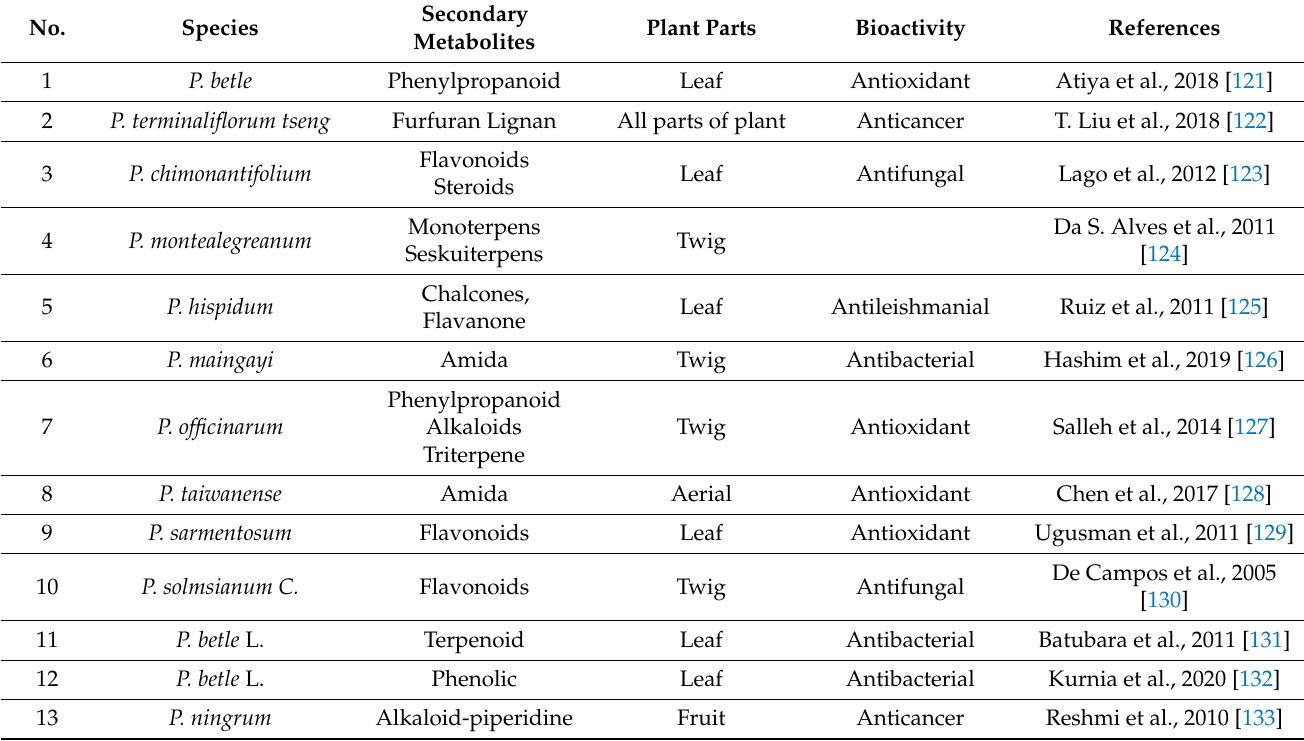
Table 1. Bioactivity of isolated Piper genus.